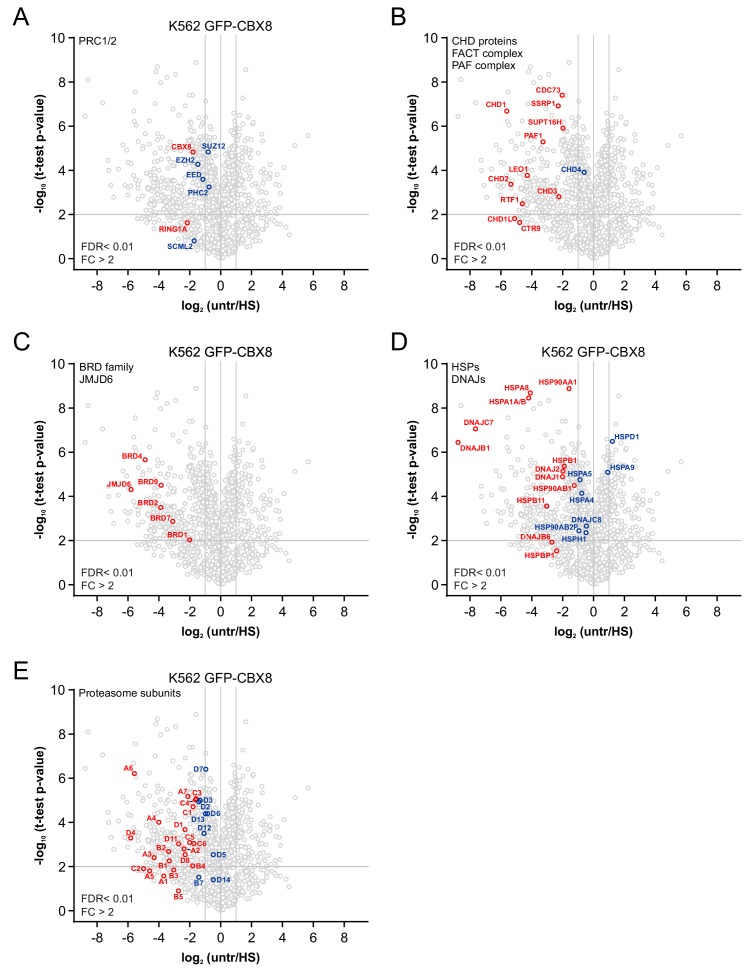
Identification of changes in the nucleolar proteome in untreated and heat shocked K562 GFP-CBX8 cells.(A) Volcano plot from nucleolar proteomes from untreated and heat shocked K562 GFP-CBX8 cells highlighting PRC1 and PRC2 subunits that were detected in the isolated nucleoli. Statistical analysis was performed using Student’s t-test (false discovery rate (FDR) < 0.01; fold change (FC) > 2). Significantly changed proteins are marked in red. (B) Volcano plot highlighting (significantly) enriched subunits of the PAF and FACT complex and CHD proteins. (C) Volcano plot showing (significantly) enriched BRD family members and the JMJD6 protein. (D) Volcano plot displaying (significantly) enriched HSP70 and DNAJ heat shock proteins. (E) Volcano plot highlighting all (significantly) enriched proteasomal subunits.